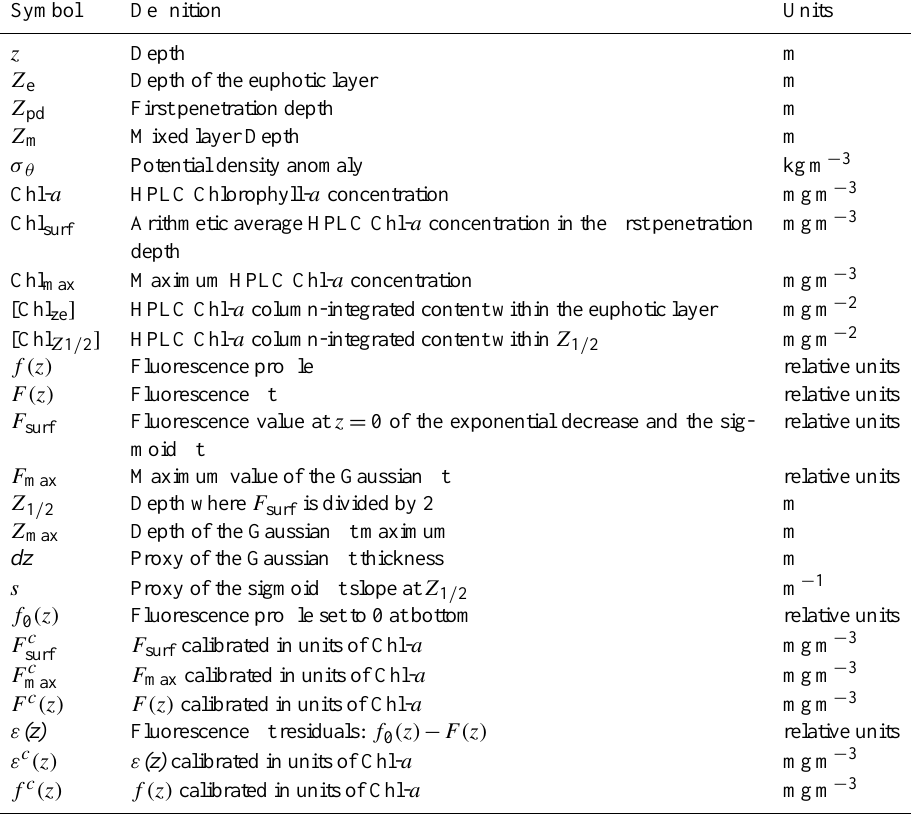
Table 1. Symbols used in this study.